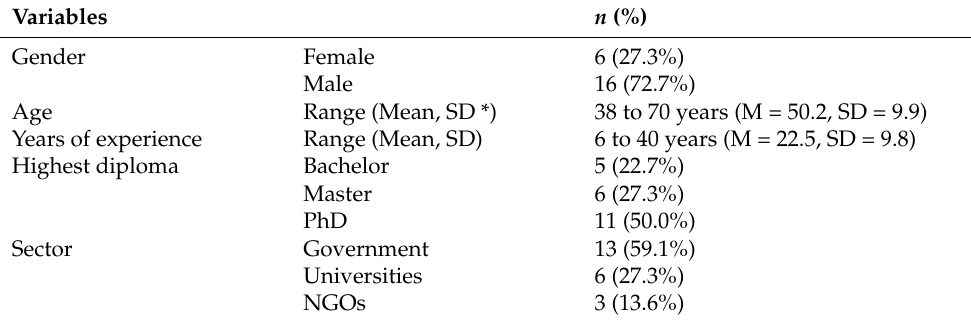
Table 1. Participant